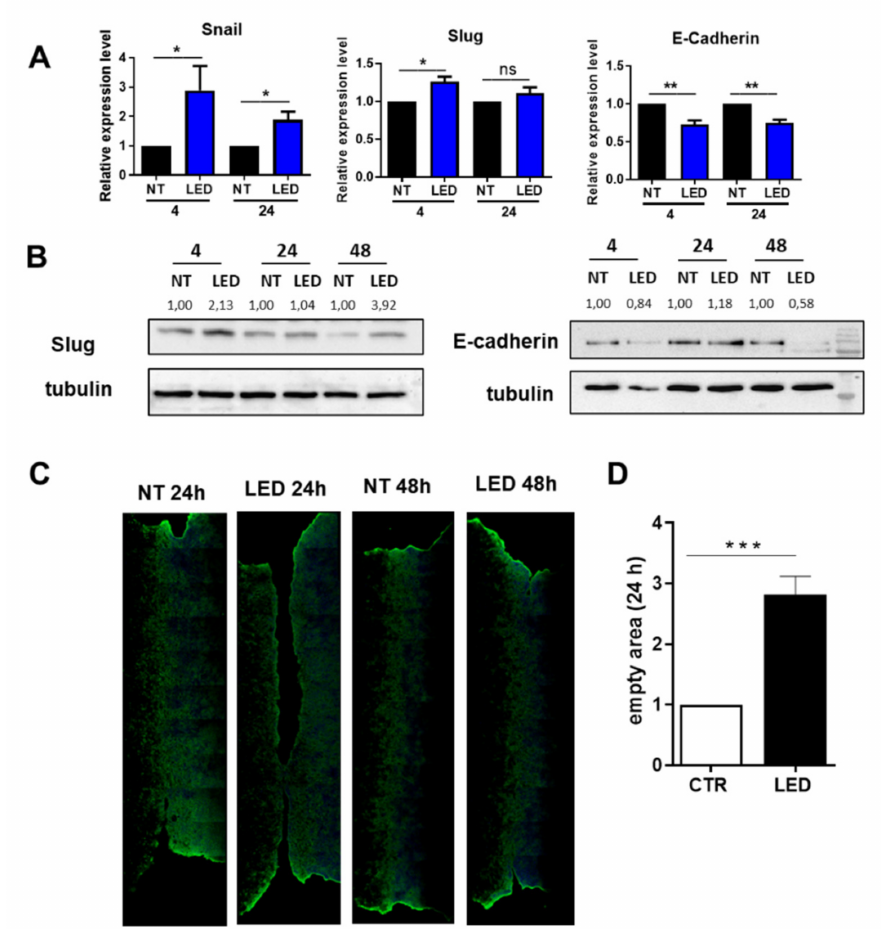
Figure 4. Exposure to b-LED causes a transient EMT phenotype with delay in wound closure. ( A ) Quantitative RT-PCR expression analysis of SNAIL, SLUG and E-cadherin in HaCaT cells exposed to b-LED for 4 h and then were analyzed 4 and 24 h after beginning of exposure. Quantitative RT-PCR was performed on total RNA. L34 mRNA levels were used for normalization. Results are expressed in term of fold change bars represent the mean ± SEM of duplicate determinations in at least five independent experiments. * p < 0.05; ** p < 0.01. ( B ) Western blot showing the expression of SLUG and E-cadherin in HaCaT cells exposed to b-LED for 4 h. Cells were analyzed 4, 24 and 48 h after the beginning of exposure to b-LED. Western blot analysis was performed on total lysates. Tubulin was detected as a loading control. Data are representative of three independent experiments. ( C ) Effect of exposure to b-LED on wound closure. HaCaT cells were left to reach 100% confluency in Ibidi µ -Dish plates. MCs were exposed to b-LED for 4 h. Then, 24 or 48 h after the beginning of exposure the insert was removed and after 18 h cells were fixed and stained with phalloidin (green) or Hoechst33342 (blue) to stain nuclei. Representative experiment is shown of three performed. ( D ) Quantification of the experiment shown in ( C ). Bars represent the mean ± SEM from three independent experiments. Two corresponding fields at time 0 and 24 h per experiments were measured. *** p < 0.001, ns, not